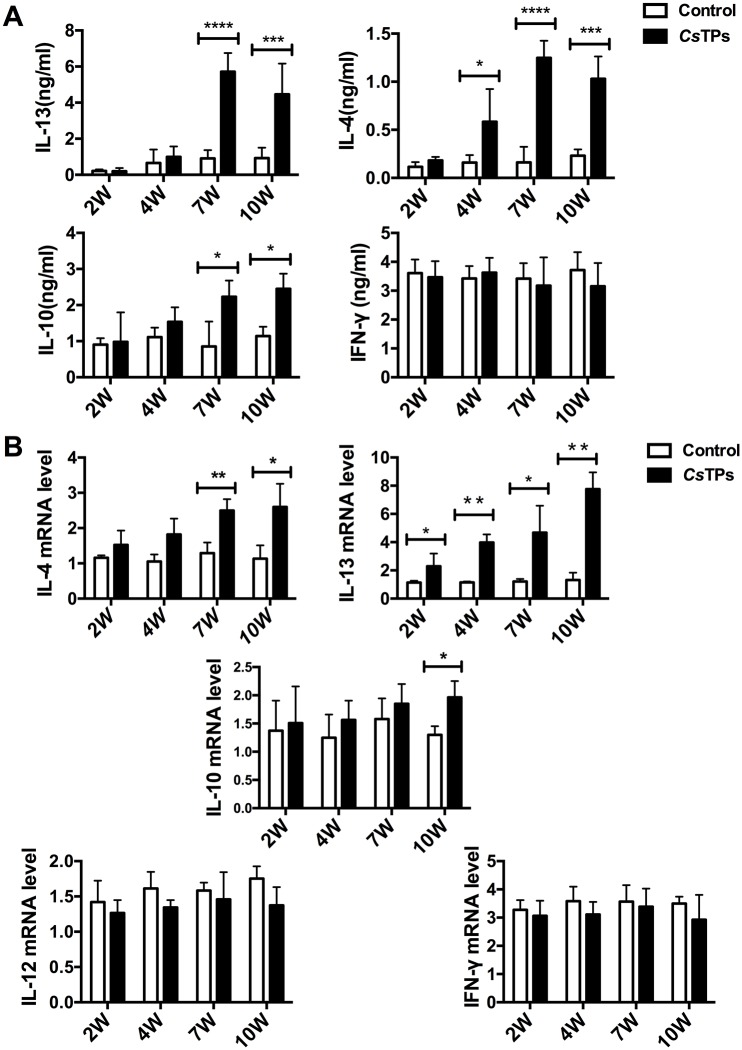
Cytokine expressions in CsTPs-immunized mice.(A) Levels of IL-13, IL-4, IL-10, and IFN-γ in splenocytes of CsTPs-immunized mice by ELISA. Mice were sacrificed 2, 4, 7 or 10 weeks after CsTPs immunization and the splenocytes were isolated. 5 × 106/ml splenocytes per well were stimulated with 1× Cell Stimulation Cocktail for 48 hours and the supernatants were analyzed. (B) mRNA levels of IL-13, IL-4, IL-10, IL-12 and IFN-γ in hepatic tissue of CsTPs-immunized mice. The livers were isolated at different time points (2, 4, 7 or 10 weeks after administration). The total RNA was extracted. Specific primers were used to detect transcripts of those cytokines by RT-PCR. All data are presented as mean ± SD of triplicate wells from 3 independent experiments with 4 mice per time point per group and analyzed by calculating 2-ΔΔCt, normalized to a housekeeping gene (β-actin). Analysis by ANOVA indicated significant differences (*, P < 0.05; **, P < 0.01; ***, P < 0.001; ****, P < 0.0001) among the different groups.